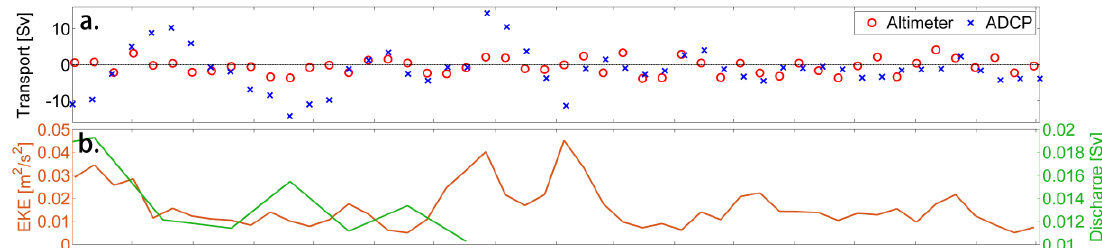
Figure 9. ( a ) Altimeter-derived and ADCP-estimated cross-shelf volume transport time series off the Pearl River Estuary during June 2015 and October 2016; ( b ) averaged eddy kinetic energy (EKE) bounded by two ground tracks and 200 m isobath and Pear River discharge time series during the same period.